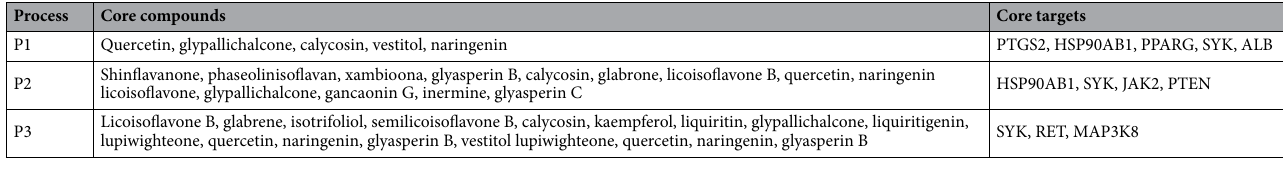
Table 5. Summary of core compounds and core targets.